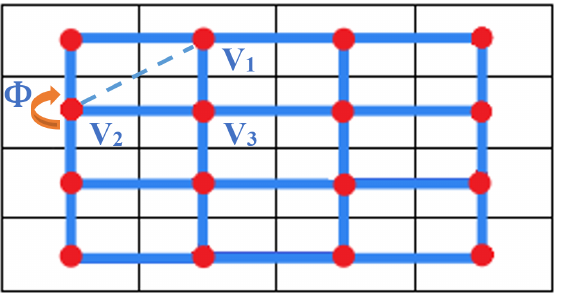
Figure 9. Graph representation: red points are vertices and blue lines represent